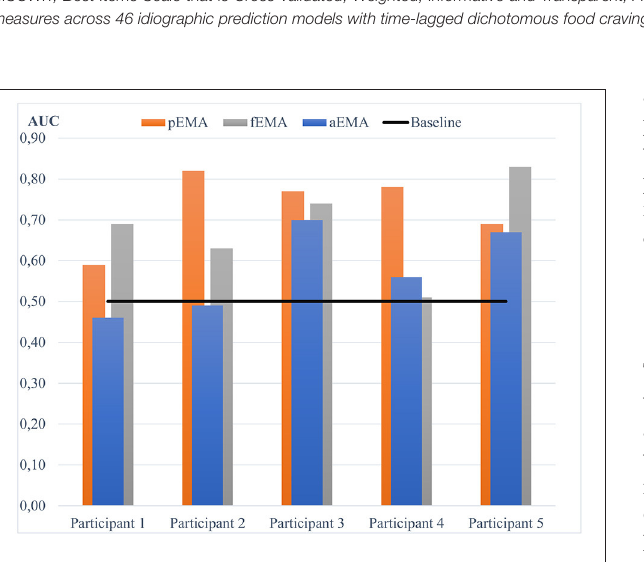
FIGURE 2 | Exemplary AUC scores for aEMA, pEMA and fEMA data obtained from 5 participants.